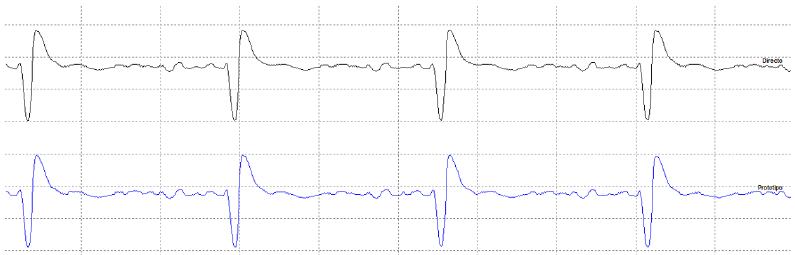
Figure 13. ECG of a healthy volunteer. Grey curve, originally obtained from the system. Blue curve, obtained from the proposed system. Voltage scale is 20µV/div, time scale is